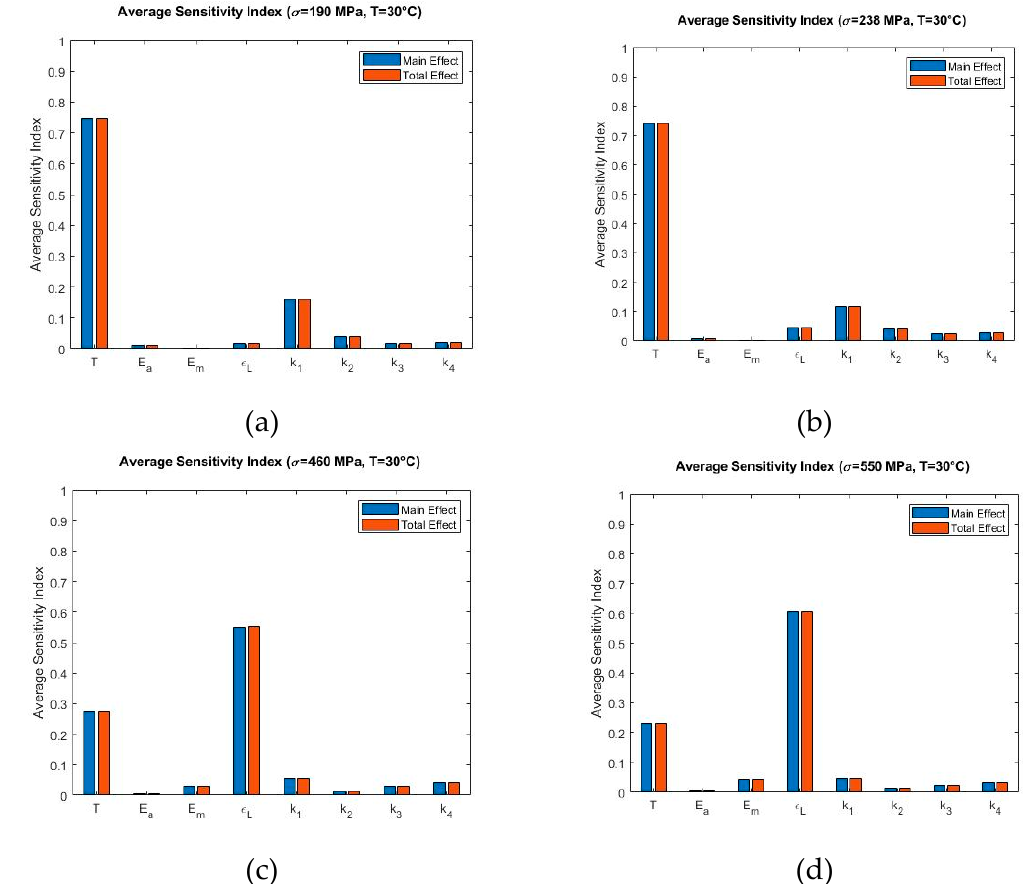
Figure 10. Sobol average sensitivity indices at simulated temperatures and maximum loading: ( a ) T = 30 ◦ C, σ max = 190 MPa ( b ) T = 30 ◦ C, σ max = 238 MPa ( c ) T = 30 ◦ C, σ max = 460 MPa ( d ) T = 30 ◦ C, σ max = 550 MPa.